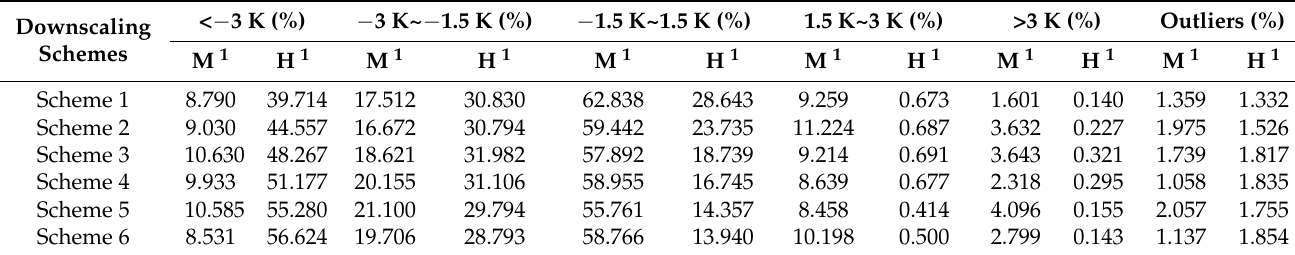
Table 13 lists the accuracy evaluation indicators of MFGWML and HUTS for the six downscaling schemes. In terms of Scheme 1, namely downscaling from 90 to 30 m, the Pearson coefficients for MFGWML and HUTS are 0.904 and 0.869, respectively, which indicates that the downscaled LSTs generated by MFGWML and HUTS are highly